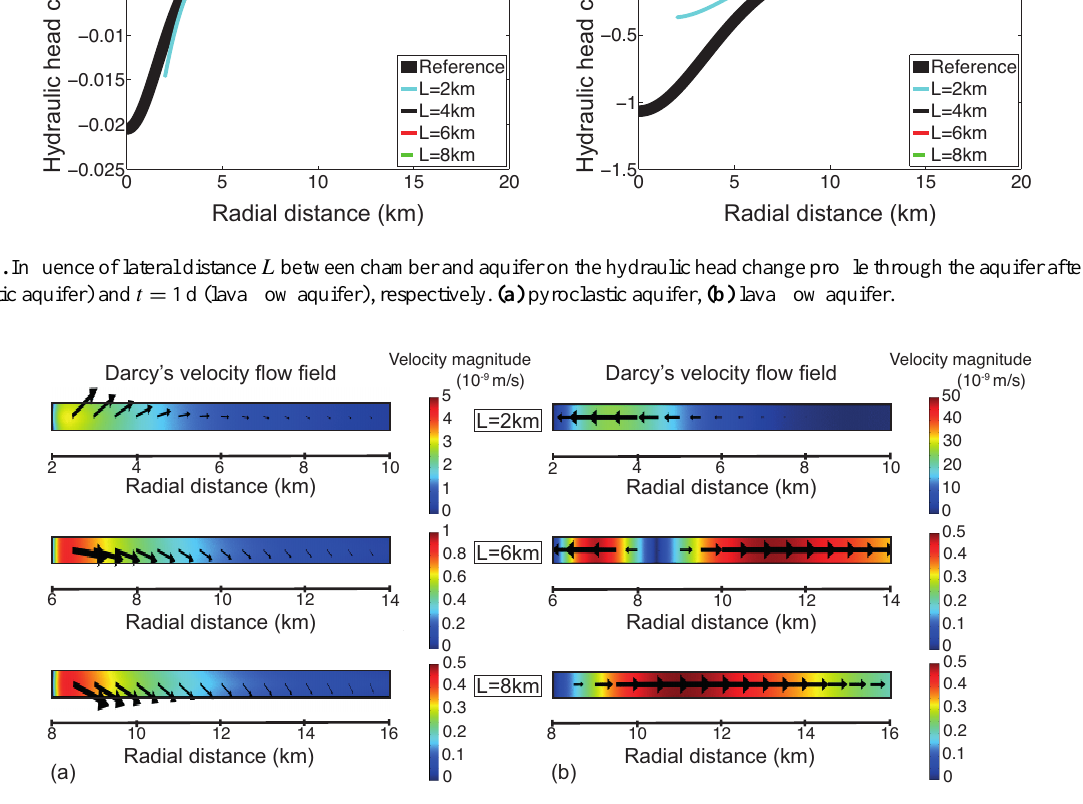
Figure 12. Influence of lateral distance L between chamber and aquifer on the flow pattern in the aquifers, here shown for t = 0 . 1d for the first 8km of each aquifer. (a) pyroclastic aquifer, (b) lava flow aquifer. Arrows indicate flow direction at the point where the arrow is attached, their length is proportional to flow velocity (different scales for a and b ), colours show velocity magnitudes. Note that arrows are upscaled for better visibility; therefore, they cross the upper aquifer boundary. However, this is only a plotting effect, there is no flow leaving the